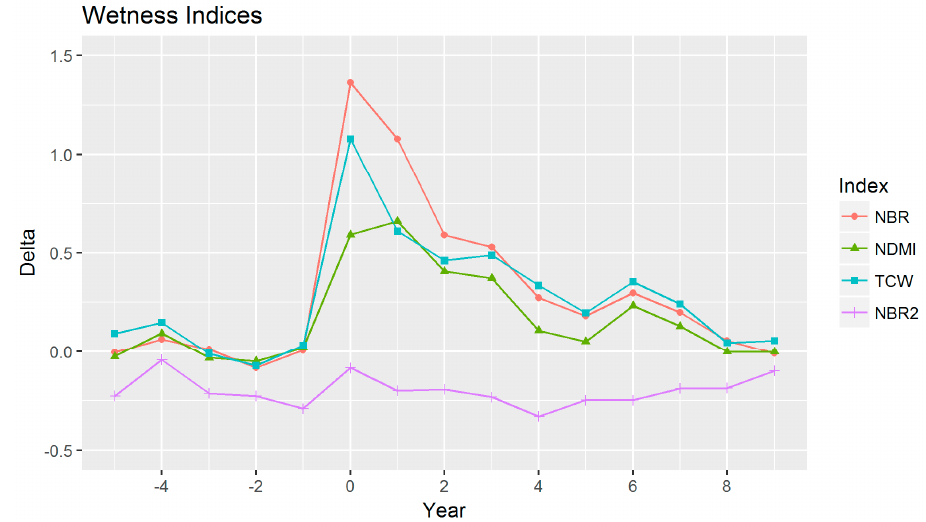
Figure 8. Mean values of textural variation for wetness indices from five years prior to fire to nine years post-fire.